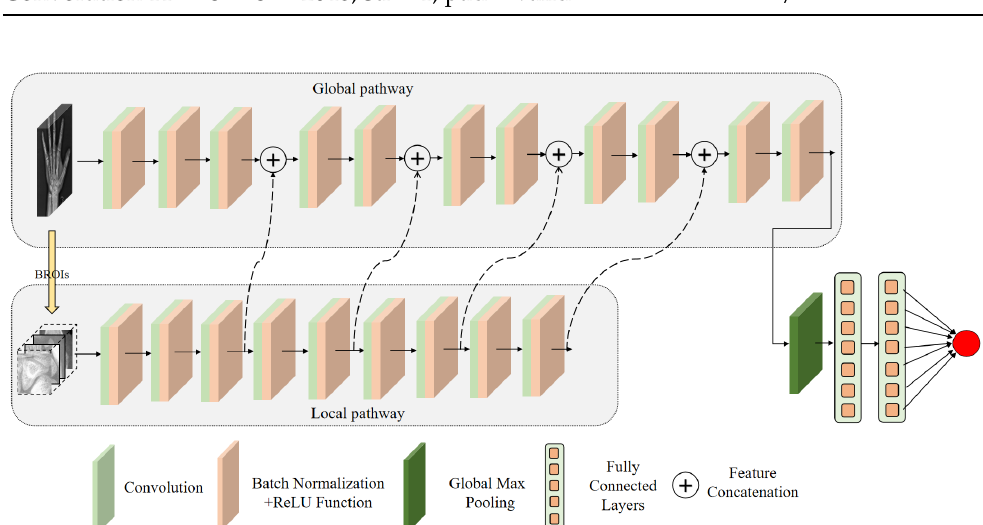
Figure 7. The framework of the global-local fusion network. The top is the global pathway to extract global information. The bottom is the local pathway to obtain local fine-grained